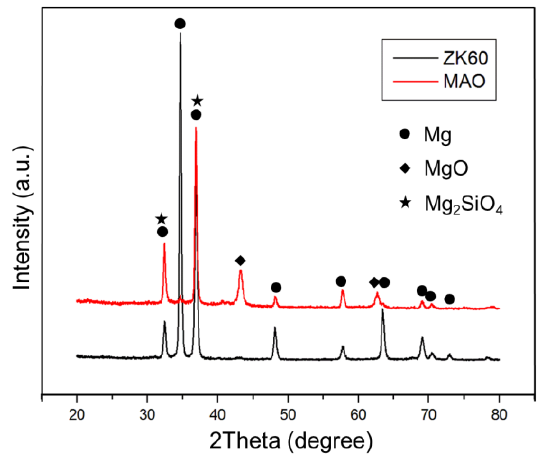
Figure 2. XRD patterns of ZK60 and MAO.